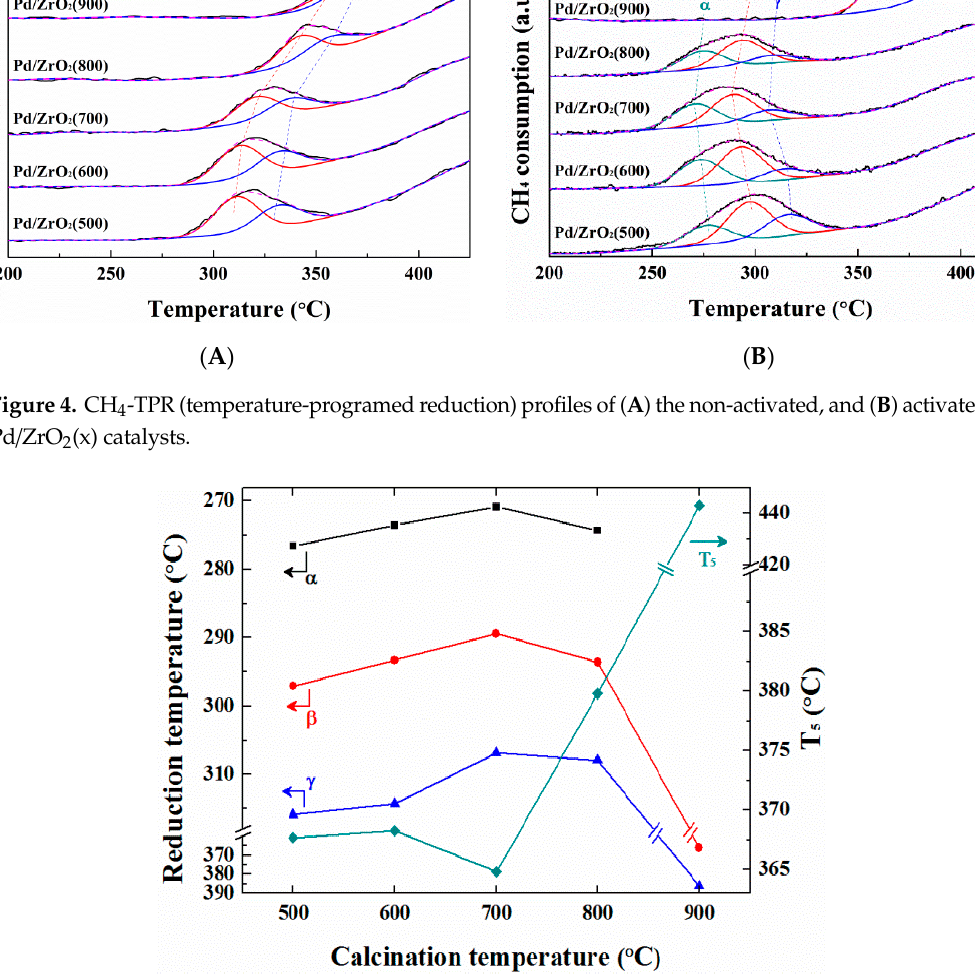
Figure 5. Correlation curves between the reduction temperatures and the T 5 values of the activated Pd / ZrO 2 (x) catalysts. The reduction temperatures and the T 5 values of the activated Pd / ZrO 2 (x) catalysts were obtained from the CH 4 -TPR and the temperature-programed reaction,